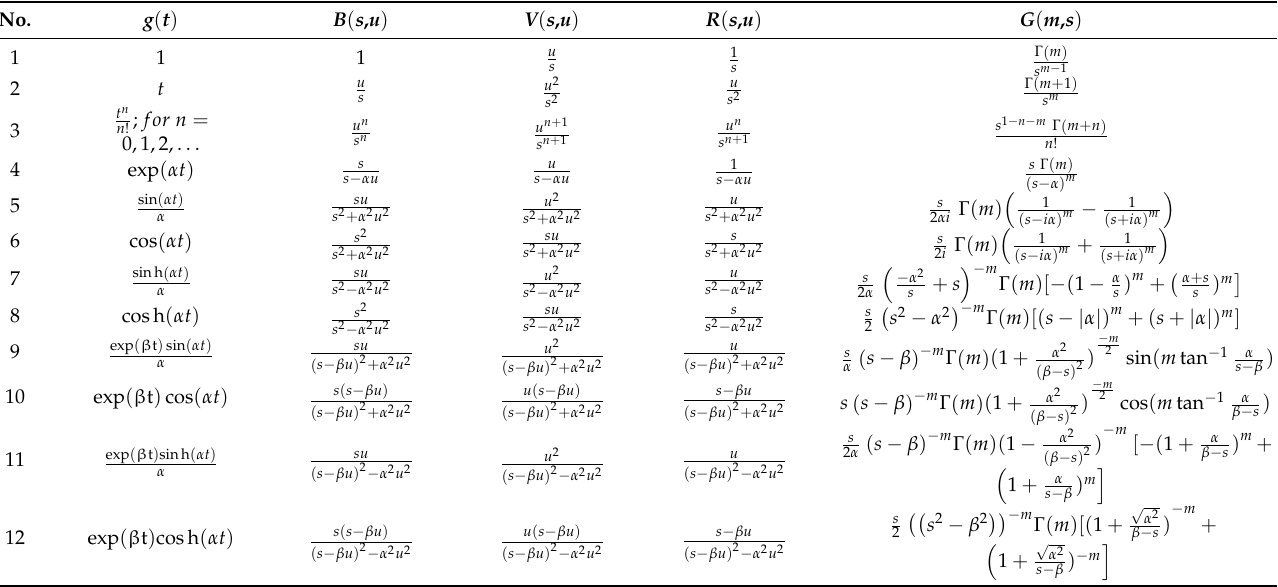
Table A5. Comprehensive list of the Formable transforms B(s,u) and their relationship with the Natural transforms R ( s , u ) , the Shehu transforms V ( s , u ) and the ARA transforms G ( m , s )